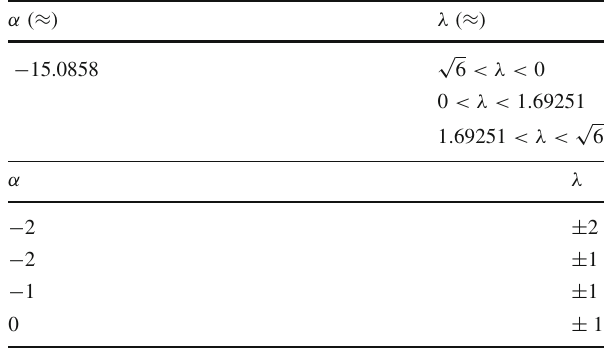
Table 3 D > 0: ranges of α and λ for distinct real eigenvalues